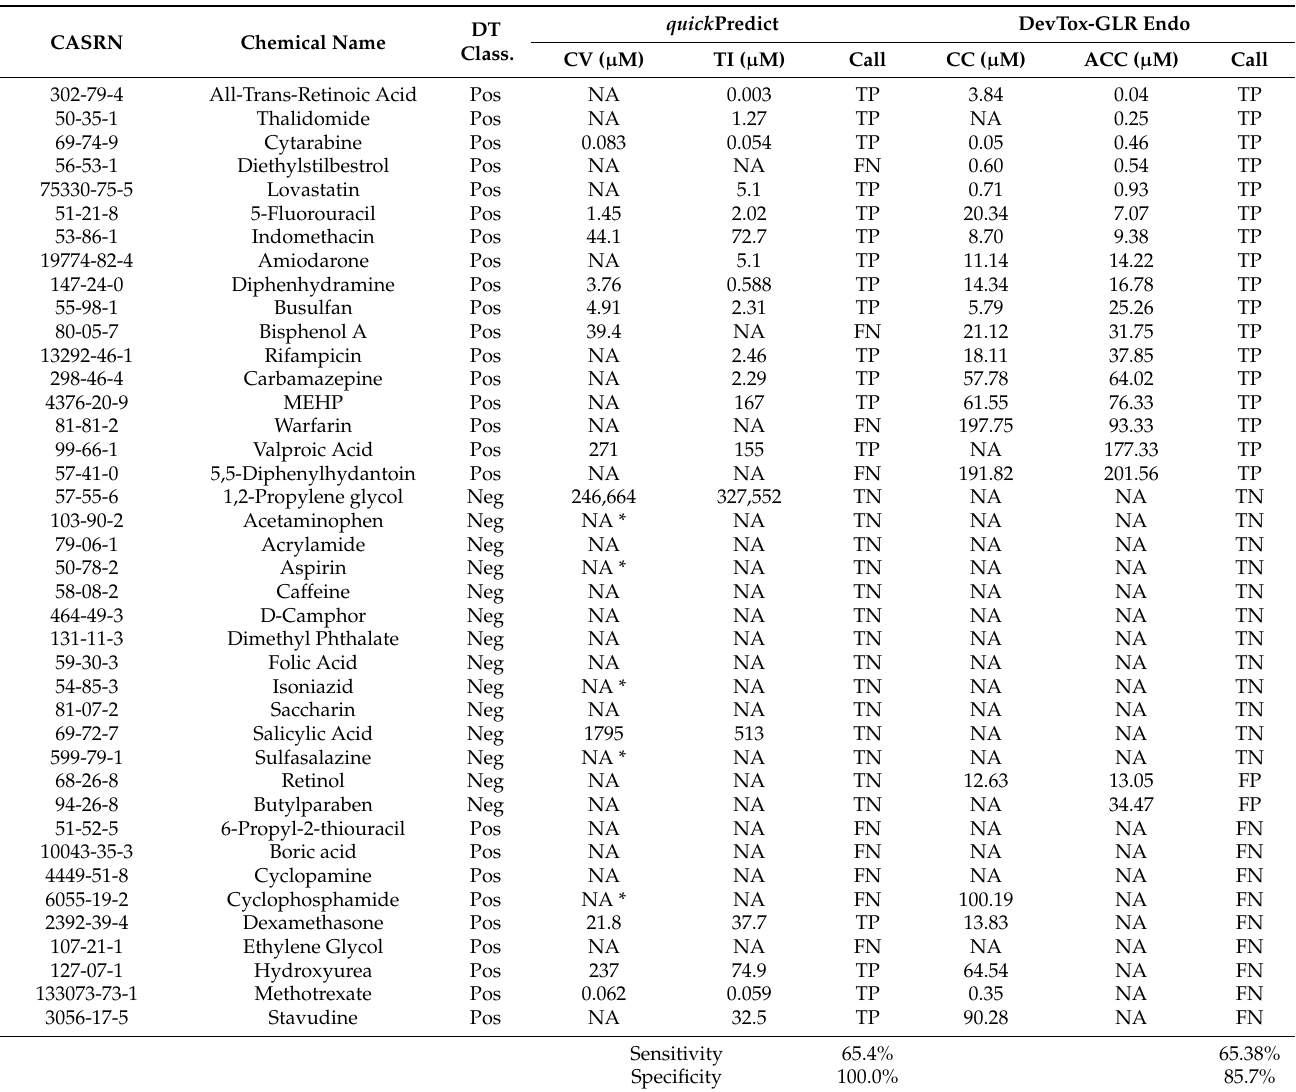
Table 4. Comparison of chemical responses between the DevTox GLR-Endo and devTOX quick Predict assays. Comparisons were drawn based on reported quick Predict assay